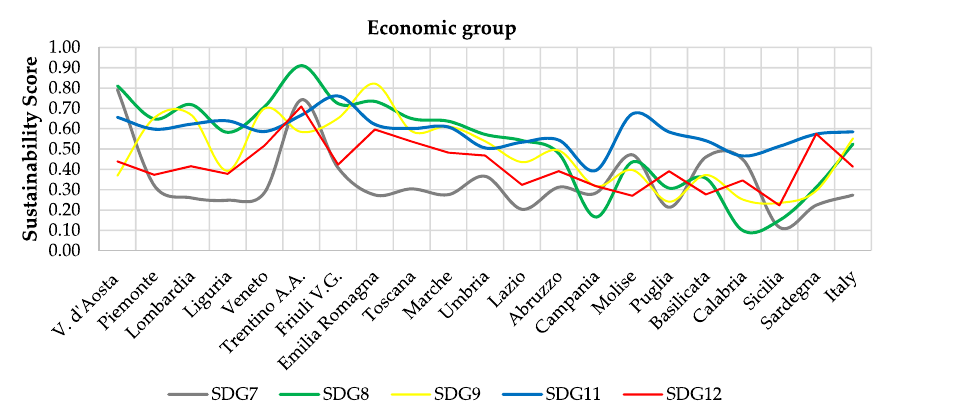
Figure 5. Sustainability Score in EWG scenario—economic